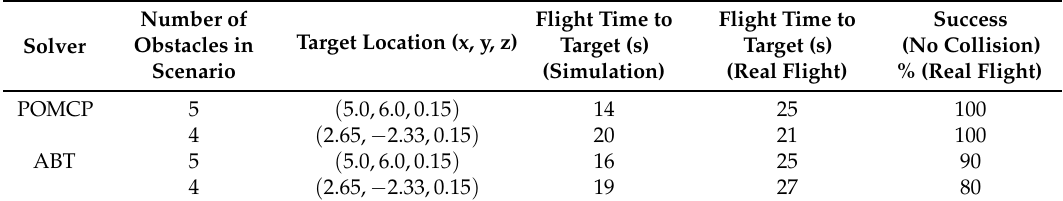
Table 3. Simulation and real flight results for Adaptive Belief Tree (ABT) and POMCP.